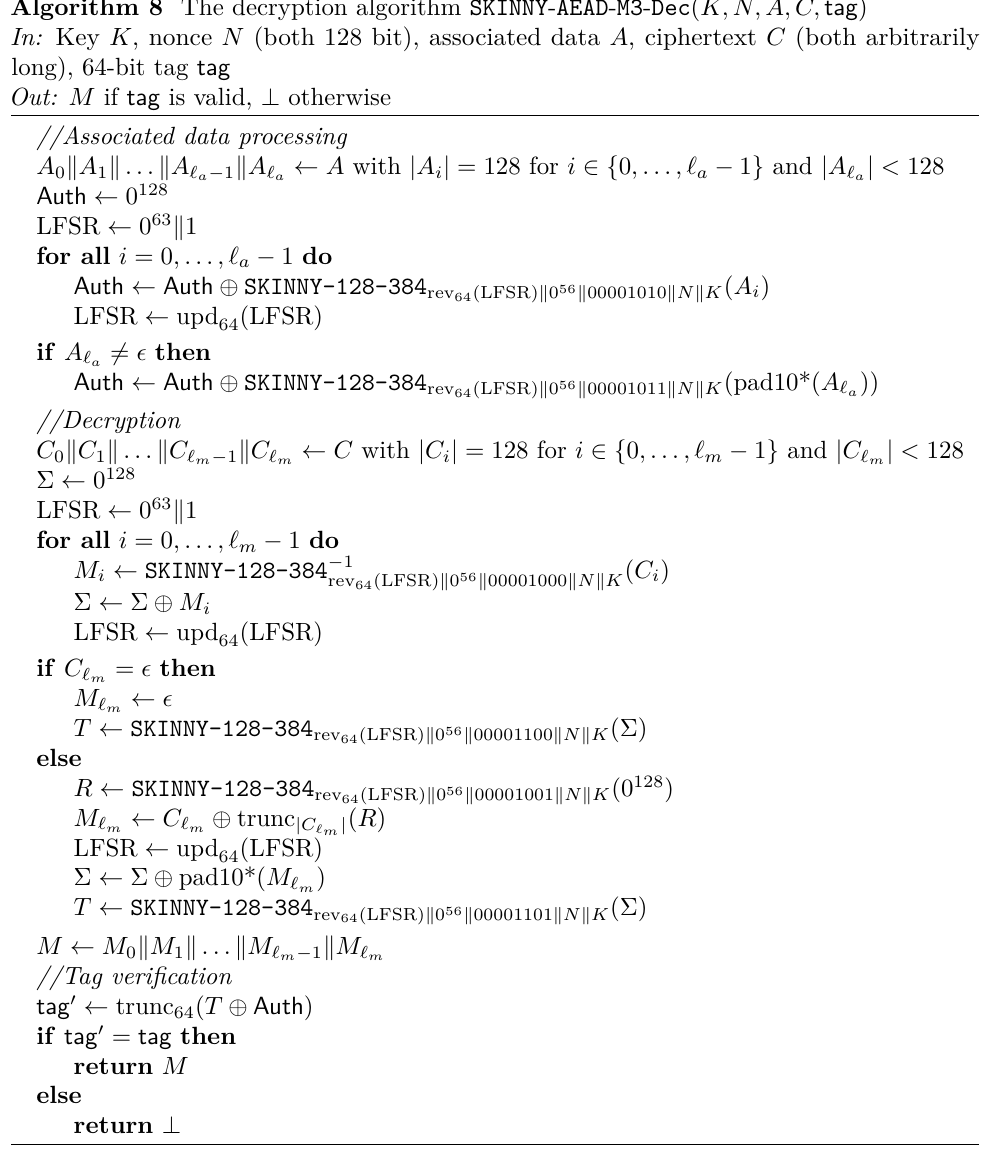
Algorithm 8 The decryption algorithm SKINNY - AEAD - M3 - Dec ( K, N, A, C, tag